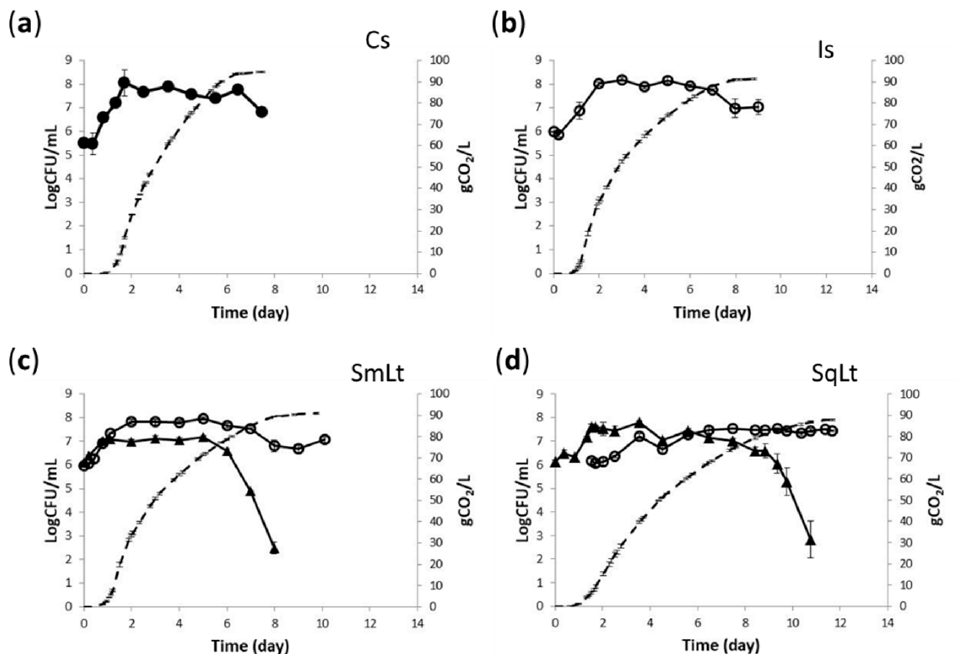
Figure 1. Yeast dynamics (continuous line) of pasteurized must with: ( a ) Cs—commercial S. cerevisiae ( ● ); ( b ) Is—indigenous S. cerevisiae PzV6 ( ○ ); ( c ) SmLt— L. thermotolerans P-HO1 ( ▲ ) and S. cerevisiae PzV6 ( ○ ) added simultaneously; and ( d ) SqLt— L. thermotolerans P-HO1 ( ▲ ) and S. cerevisiae PzV6 ( ○ ) added sequentially. Dashed line indicates CO 2 release.